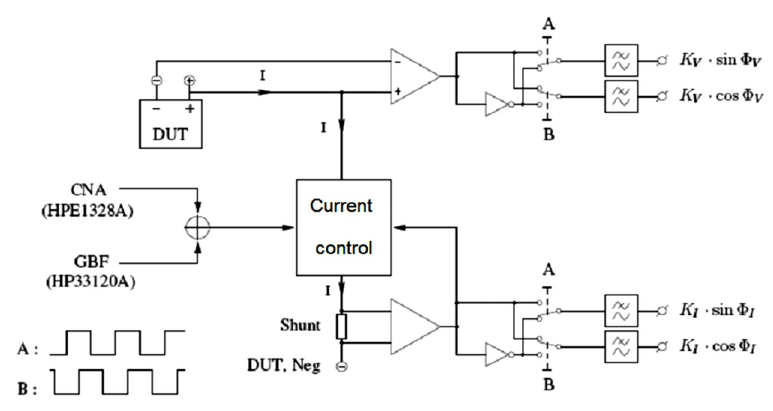
Figure 4. Synoptic of the test bench.